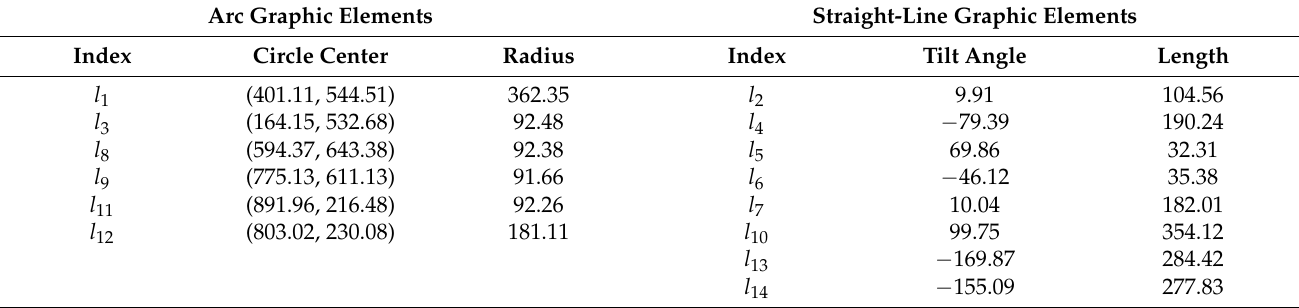
Table 4. Results of fitting on experimental